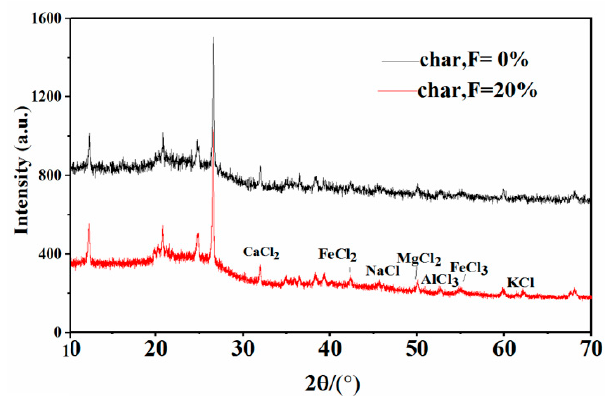
Figure 7. XRD pattern of the char at 600 °C. Table 5. Content of chemical compounds and chlorine in the char.